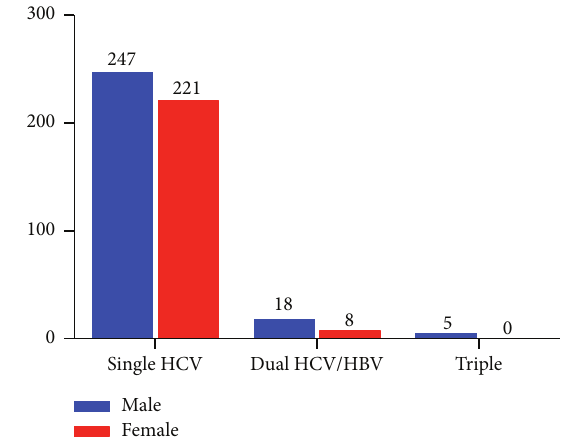
Figure 4: Bar graph representing the genderwise distribution of single, dual, and triple